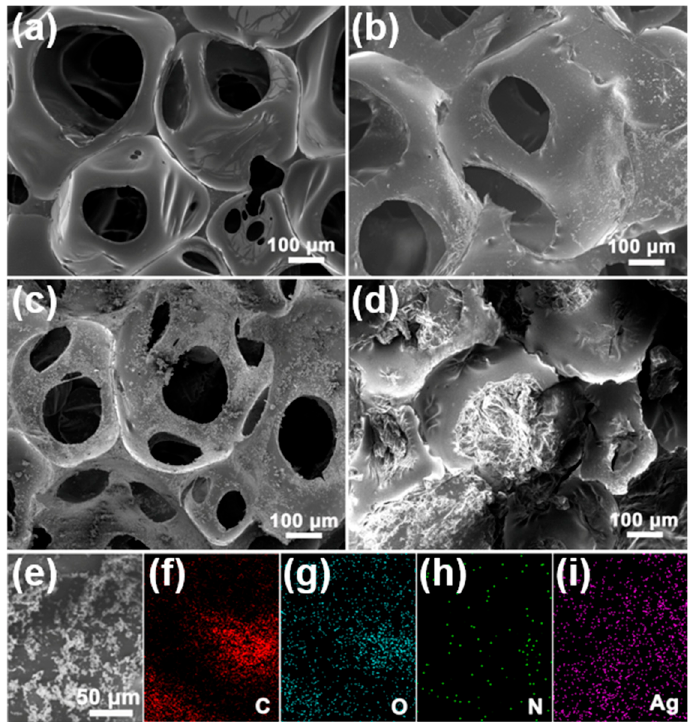
Figure 1. SEM images of ( a ) PU, ( b ) UP, ( c ) UPA3, ( d ) UPA3/PW and ( e – i ) elemental mapping images of UPA3.